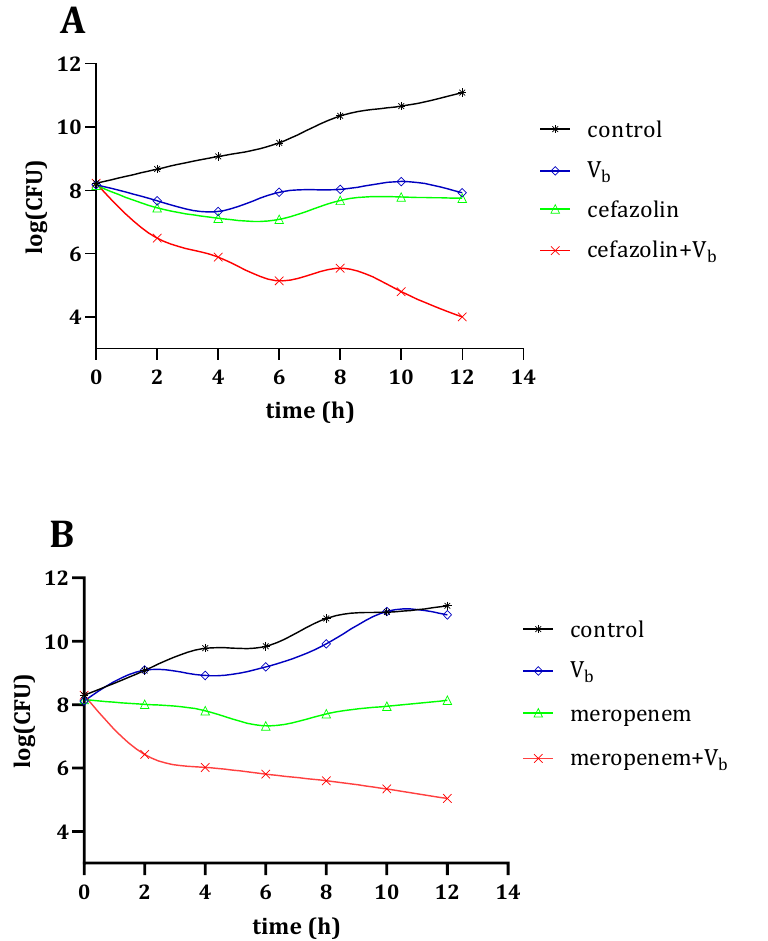
Figure 3. Time-kill kinetic analysis of V b -, antibiotics- and synergetic therapy-treated S. aureus ( A ) and K. pneumonia ( B ) for 12 h.